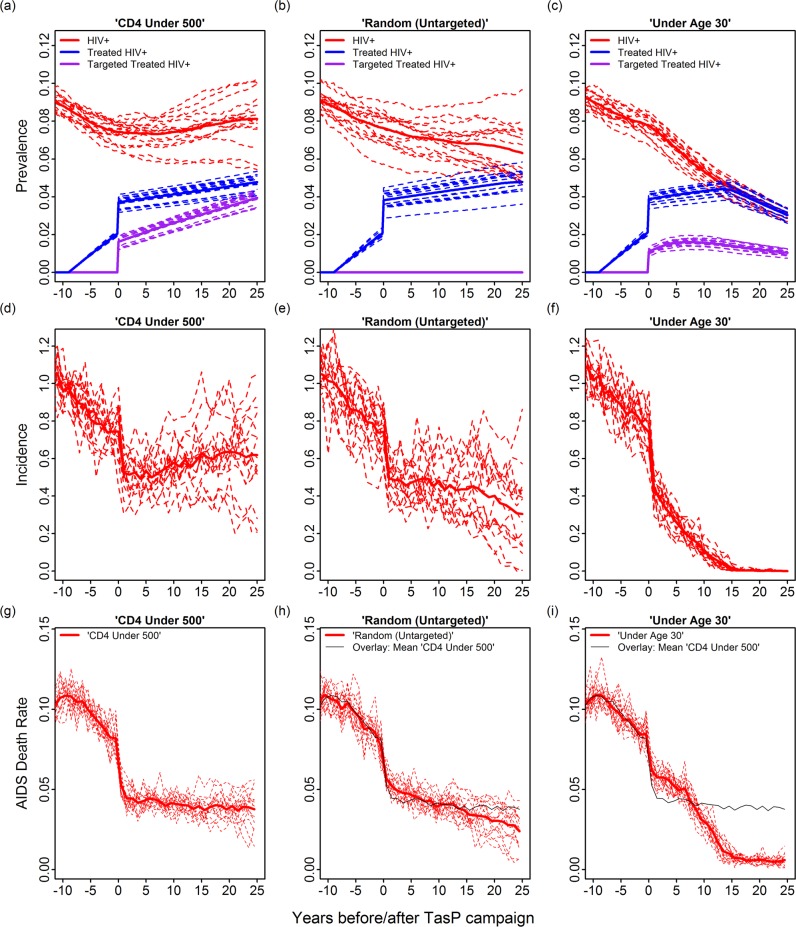
Simulations showing the percent of the population that is HIV+ (panels a-c, red lines), HIV+ and receiving treatment (panels a-c, blue lines), and HIV+ and receiving treatment specifically due to being part of a target group (panels a-c, purple lines); incidence (panels d-f); and AIDS death rates (panels g-h) following our “CD4<500” (left-side), “random” (middle), and “under age 30” (right side) treatment-as-prevention (TasP) strategies. To account for existing treatment, we assume a linear increase in the number of people receiving suppressive therapy beginning nine years before the TasP campaign. The TasP campaign immediately increases the percentage of HIV+ people receiving therapy to ~60%. Once the TasP campaign starts, the model uses the CD4-, random- or age-based strategies to link a subset of unsuppressed diagnosed people to care. The 2%/yr increase in the number treated after the campaign reflects population growth and generalized increases in health care efficiency or expenditures. Thick lines give the mean of 16 independent replicates; thin dashed lines show individual runs. The decline in prevalence of treated people after year 15 in panel c (blue lines) occurs because prevalence decreases once all infected agents are treated. The black lines in panels h and i give the means from the CD4<500 simulations in panel g (to highlight differences between short- versus long-term effects of “CD4<500” and “Under age 30”). For these simulations, we set the initial population size to 20,000 to reduce run-to-run variation.